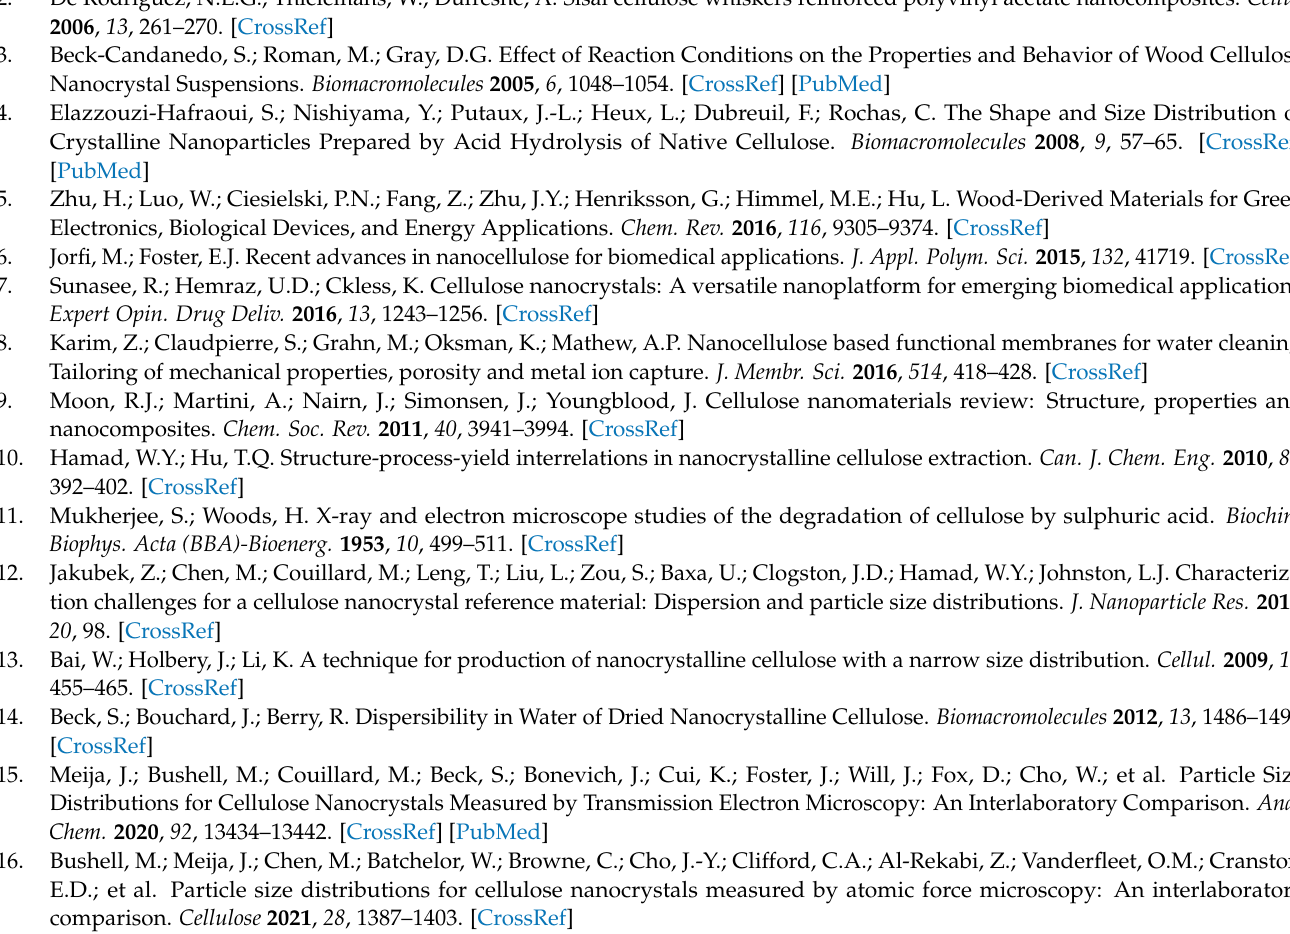
particle arrangements, Figure S2: Stain-depth variation of CNCs deposited on TEM grid, Table S1: Length and width distributions measured from BF-TEM, ADF-STEM and cryo-TEM images of CNCs, Figure S3: Histograms of length, width and aspect ratio distributions of CNCs measured from images taken in Zones A1, A2 and A3 of stained CNCs on TEM grids (Specimen Sp1), Figure S4: Histograms of length and width distributions for unstained CNCs from TEM specimen Sp2 and cryo-TEM specimen Sp4, Figure S5: Initial droplet of CNC aqueous solution on continuous carbon-film-coated TEM grids and perforated carbon-film-coated TEM grids, Figure S6: Size distribution of CNCs by combining Datasets A1, A2 and A3 measured from Specimen